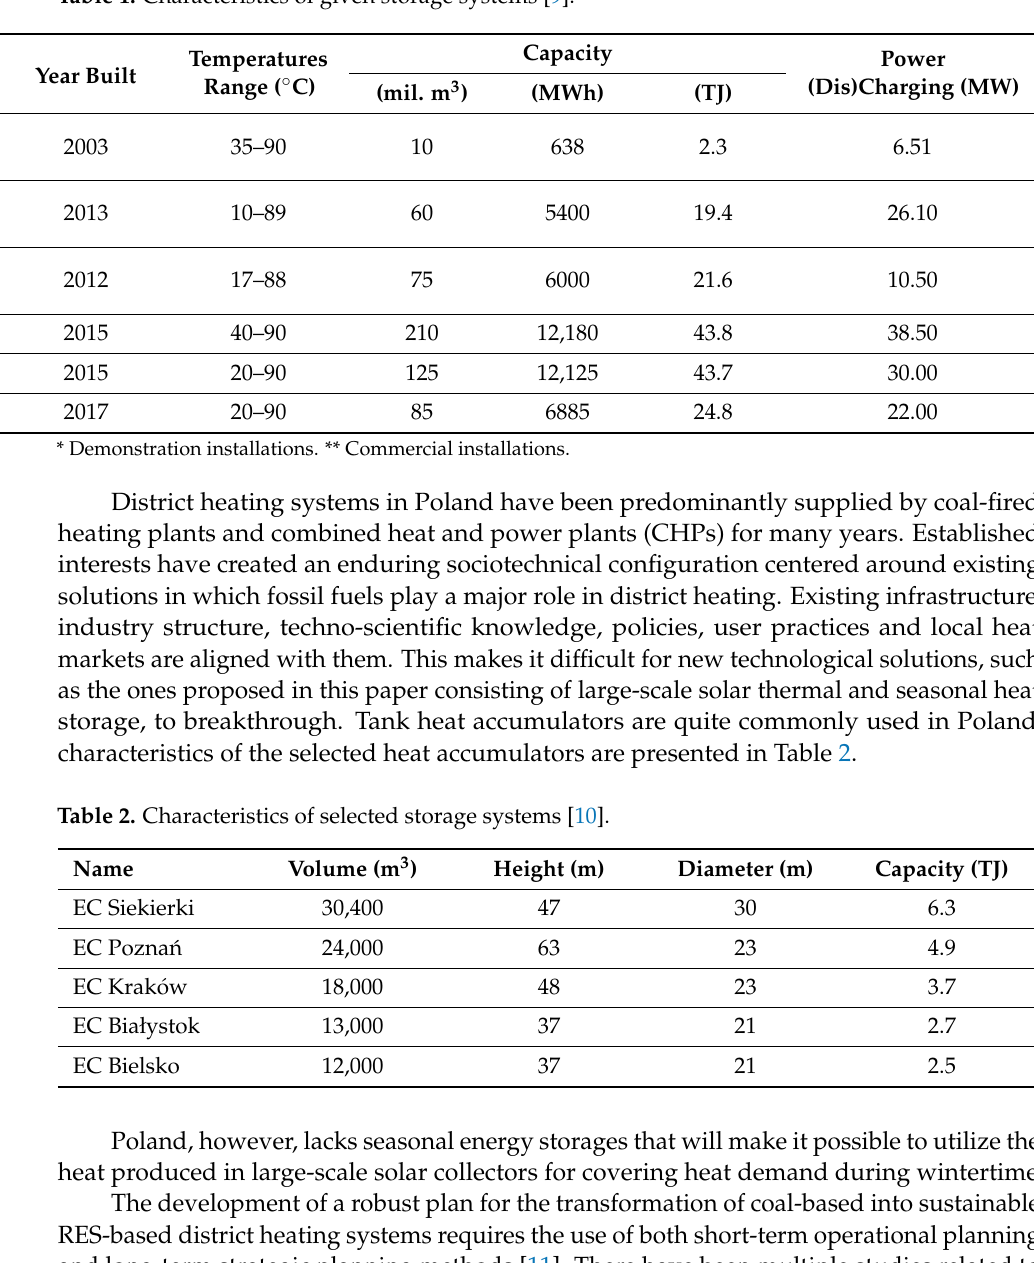
Table 1. Characteristics of given storage systems [9].